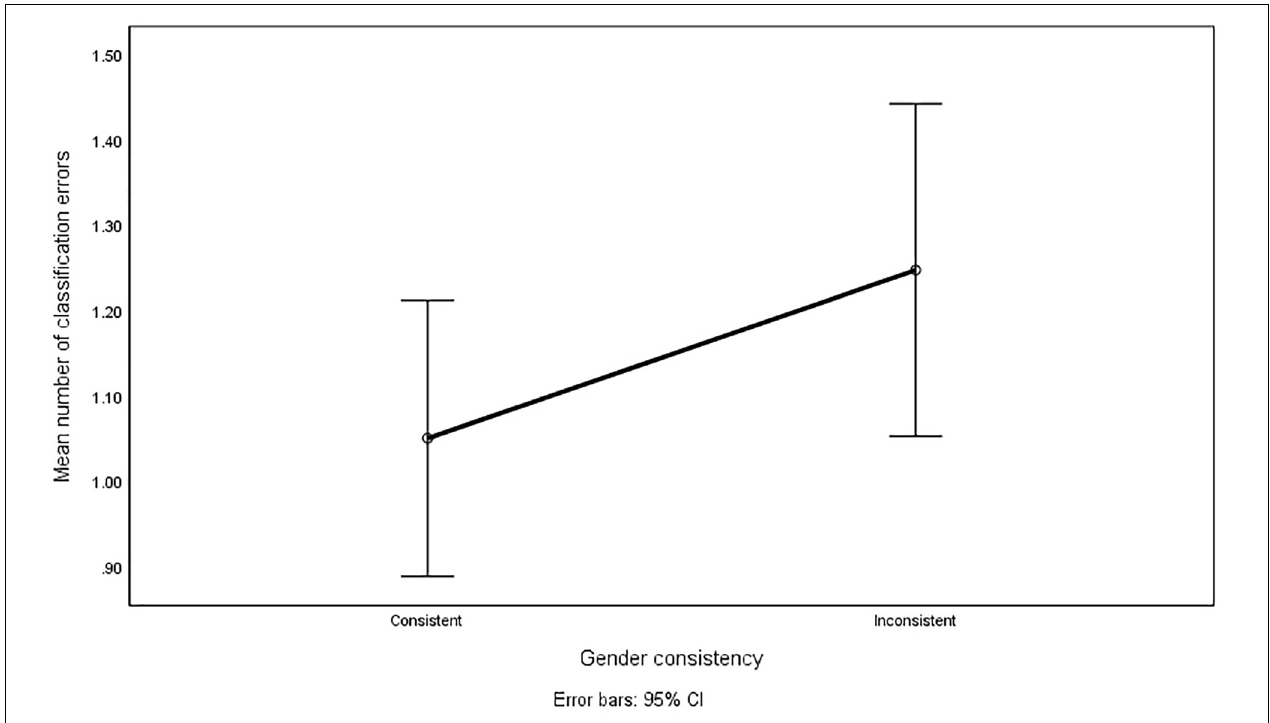
FIGURE 3 | Classification errors in gender-consistent and gender-inconsistent